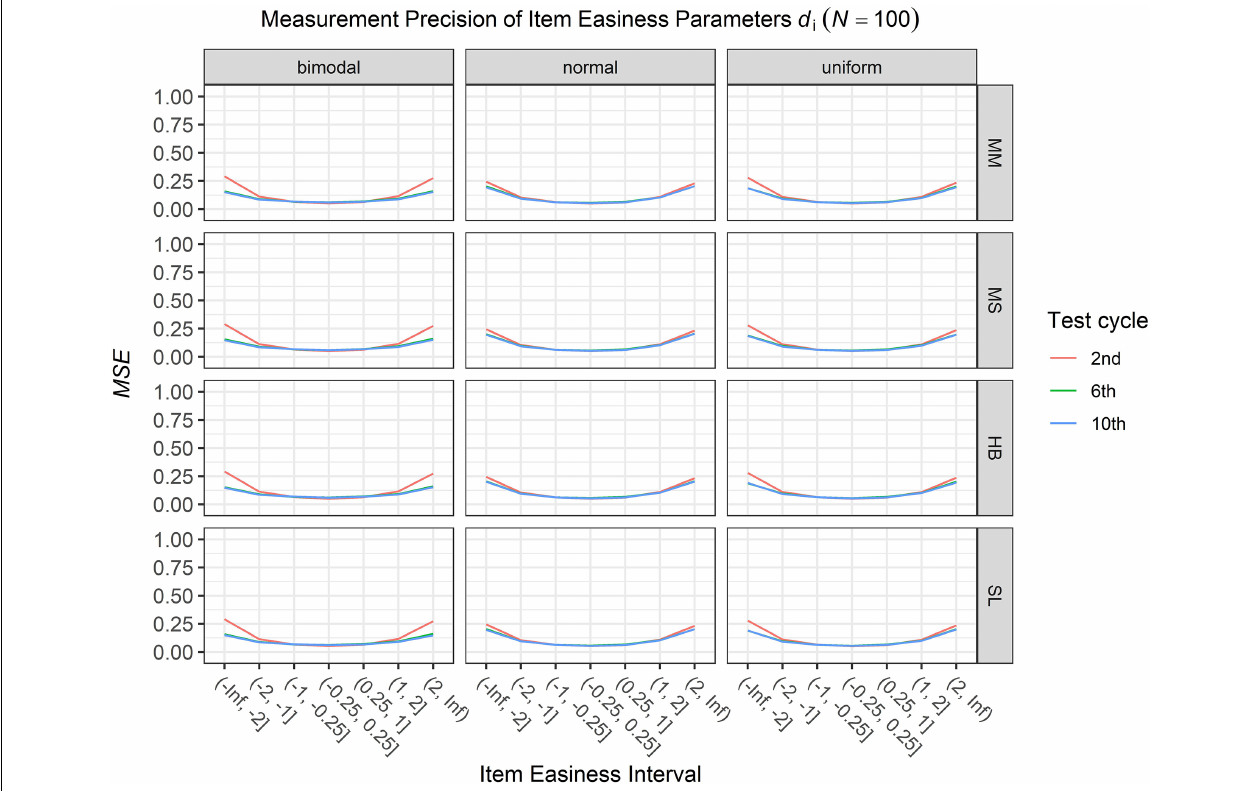
FIGURE 5 | Conditional mean squared error ( MSE ) of the item easiness d i for specific item easiness intervals after 2nd, 6th, and 10th test cycle in the continuous calibration strategy with a sample size per test cycle of N = 100 for different common item difficulty distributions and different scale transformation methods (MM = Mean/Mean, MS = Mean/Sigma, HB = Haebara, SL =